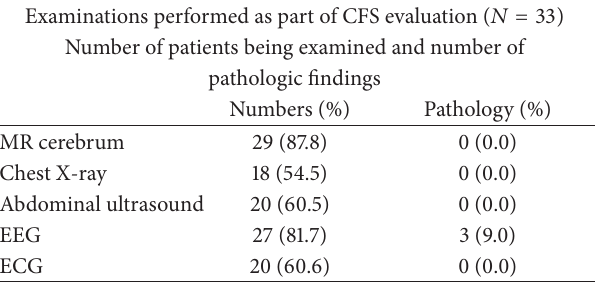
Table 1: Medical examination in a population of children and adolescents with fatigue symptoms ( 𝑁 = 33 ).